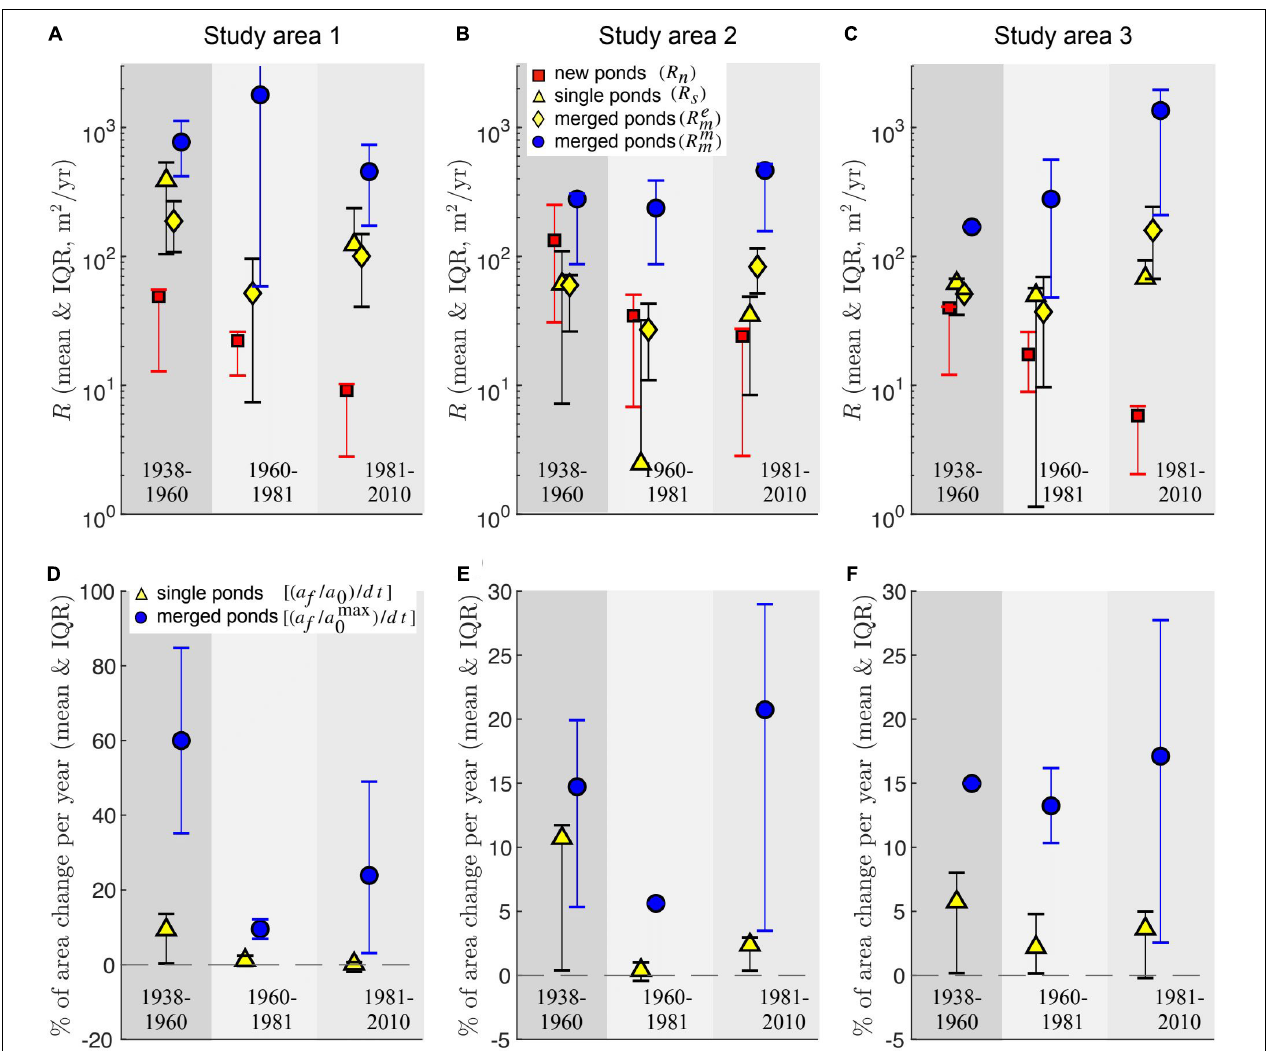
FIGURE 4 | Different area growth rates quantifying pond change (A–C) and relative change in pond area per year (D–F) area for the three time intervals and study areas. Symbols are error bars represents the mean and Interquartile range (IQR), respectively. IQR is defined as the difference between the 75th and the 25th percentiles. The relative change in pond area is defined as the ratio (a f / a 0 ) between final and initial pond area divided by the time interval (cid:52) t. For merged ponds the initial pond area corresponds to the largest merging pond. The relative change in pond area is undefined for new ponds.